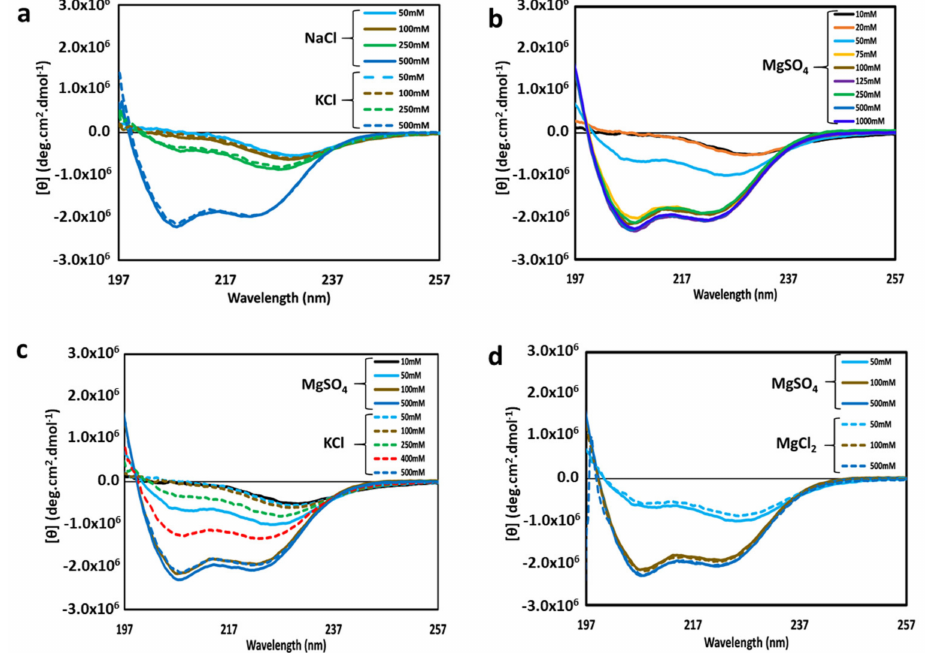
Figure 2. Overlay of circular dichroism (CD) spectra of cl-Par-4 at various concentrations of the following salts: ( a ) NaCl (solid lines) and KCl (dashed lines); ( b ) MgSO 4 ; ( c ) MgSO 4 (solid lines) and KCl (dashed lines); ( d ) MgSO 4 (solid lines) and MgCl 2 (dashed lines). The salt concentrations are indicated by the color legend within each panel. All spectra were recorded at pH